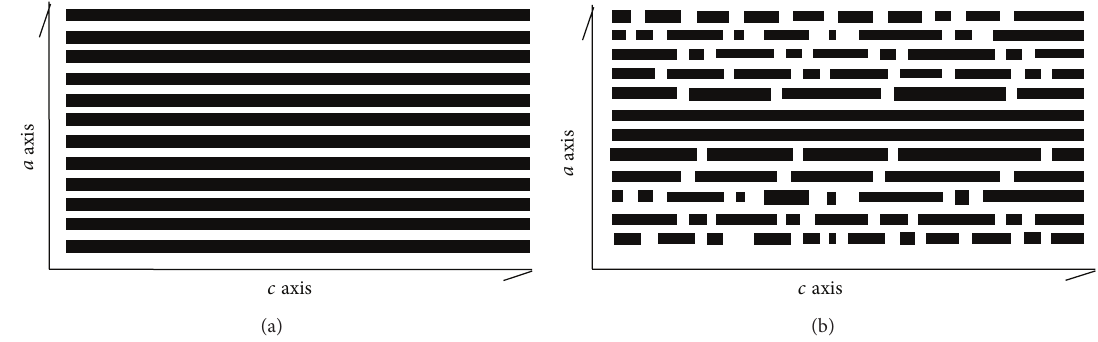
Figure 2: The channel structure change of palygorskite with acidification treatment [6]. (a) The original channel structure of palygorskite. (b) The channel structure of palygorskite after acidification with hydrochloric acid.